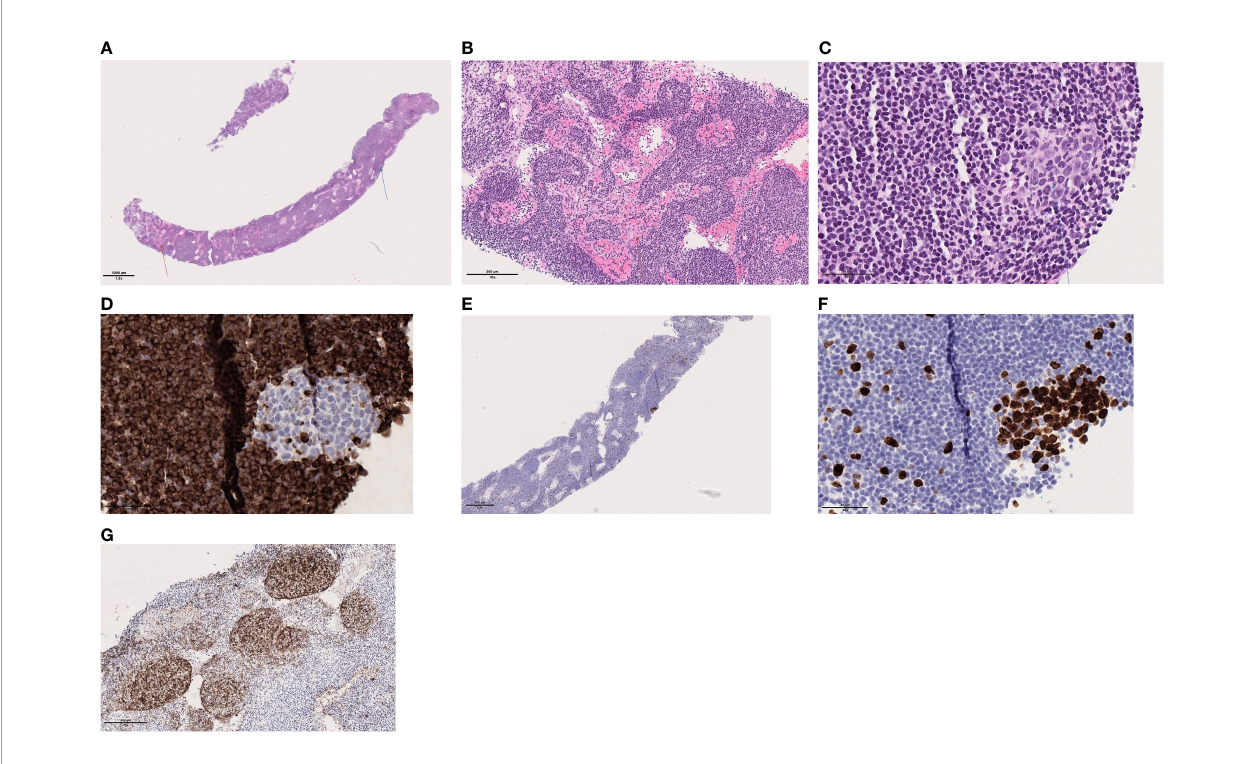
FIGURE 1 | (A) Lymph node with preserved architecture, sinus histiocytosis (red arrow) and a germinal center (blue arrow), (B) Sinus histiocytosis, (C) Secondary follicle with germinal center, (D) BCL2 is negative within the secondary lymphoid follicle, (E) Ki64/MIB1: shows high proliferation in the germinal center within the secondary follicle; and low outside, (F) Ki64/MIB1: shows high proliferation in the germinal center within the secondary follicle and (G) CD1 shows the follicular dendritic network associated with the follicles. These are mainly primary follicles.